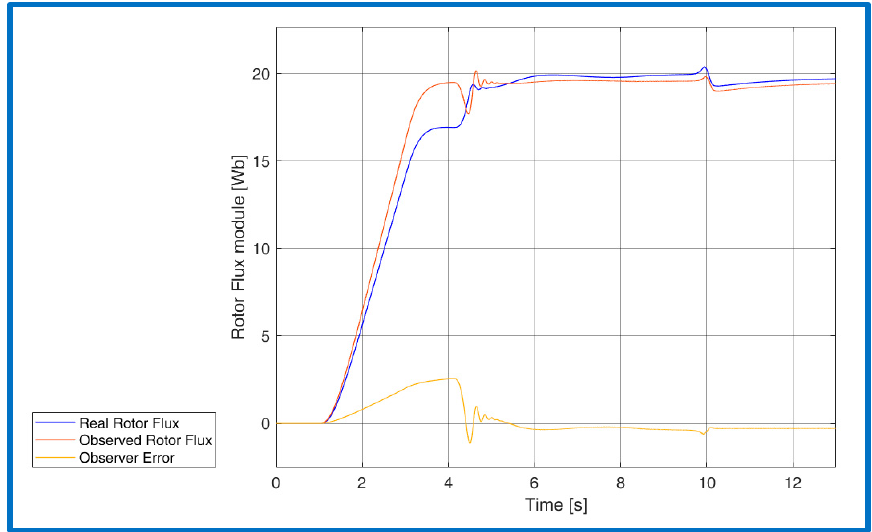
Figure 17. Real rotor flux module (blue), observed rotor flux module (red), and observer error (yellow), with π cable model and inverter.